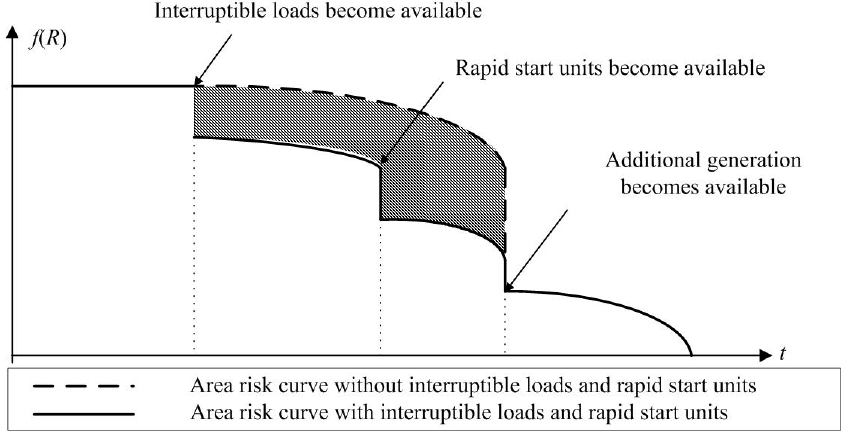
Figure 1. The area risk curves with and without rapid start units and other equivalent reserve.